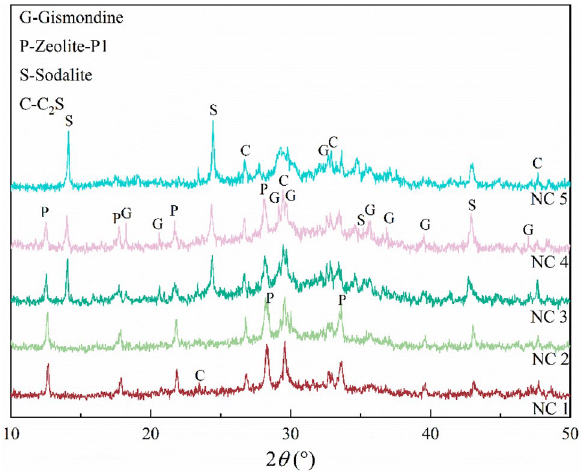
Figure 3. XRD patterns of hydrothermal products with different NaOH concentration; NC 1: the NaOH concentration is 1 mol/L, NC 2: the NaOH concentration is 2 mol/L, NC 3: the NaOH concentration is 3 mol/L, NC 4: the NaOH concentration is 4 mol/L, NC 5: the NaOH concentration is 5